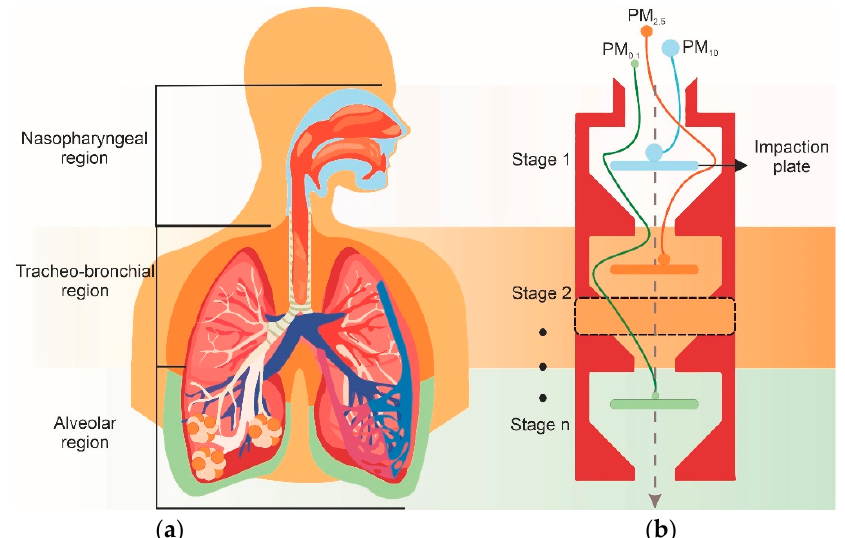
Figure 1. Illustration of ( a ) the predicted fractional deposition of inhaled particles in the nasopha- ryngeal (blue), tracheobronchial (orange), and alveolar (green) regions of the human respiratory tract during nose breathing, and ( b ) airborne particle classification by the Equivalent Aerodynamic Diameter of PM 10 (blue), PM 2.5 (orange), and PM 0.1 (green) particles using a CI.